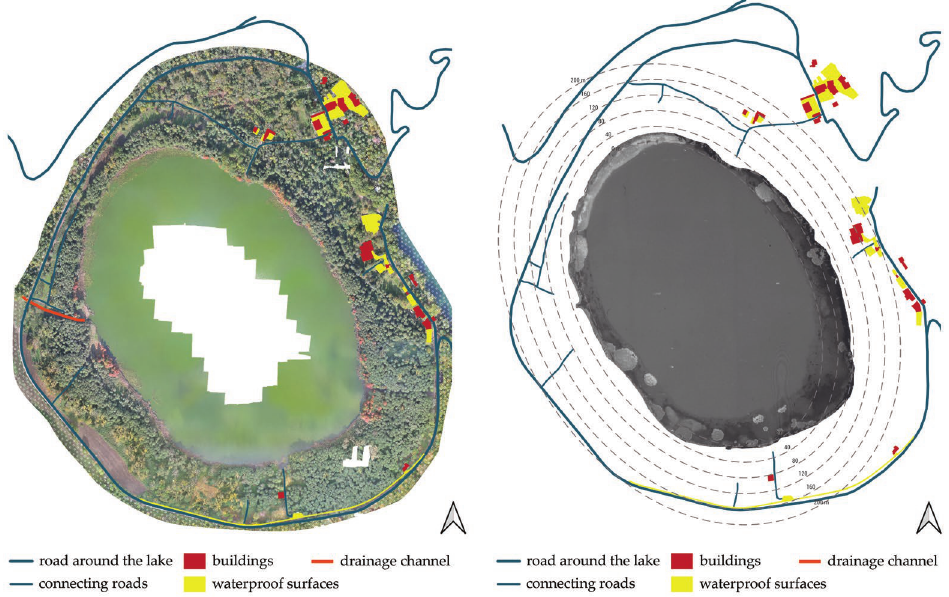
Figure 10. Structures and infrastructures in the area surrounding the lake.